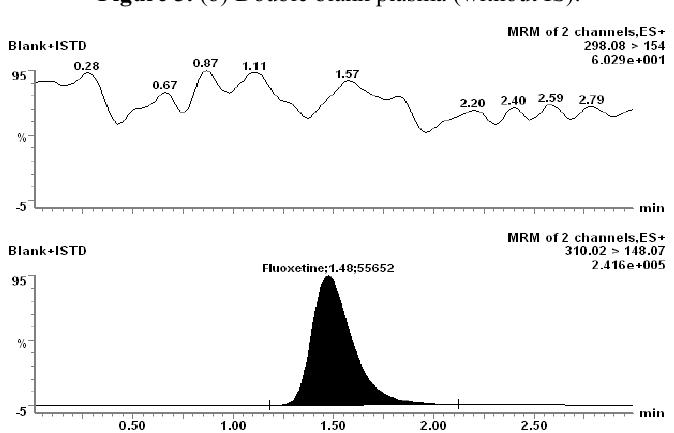
Figure 3. (c) Blank plasma with